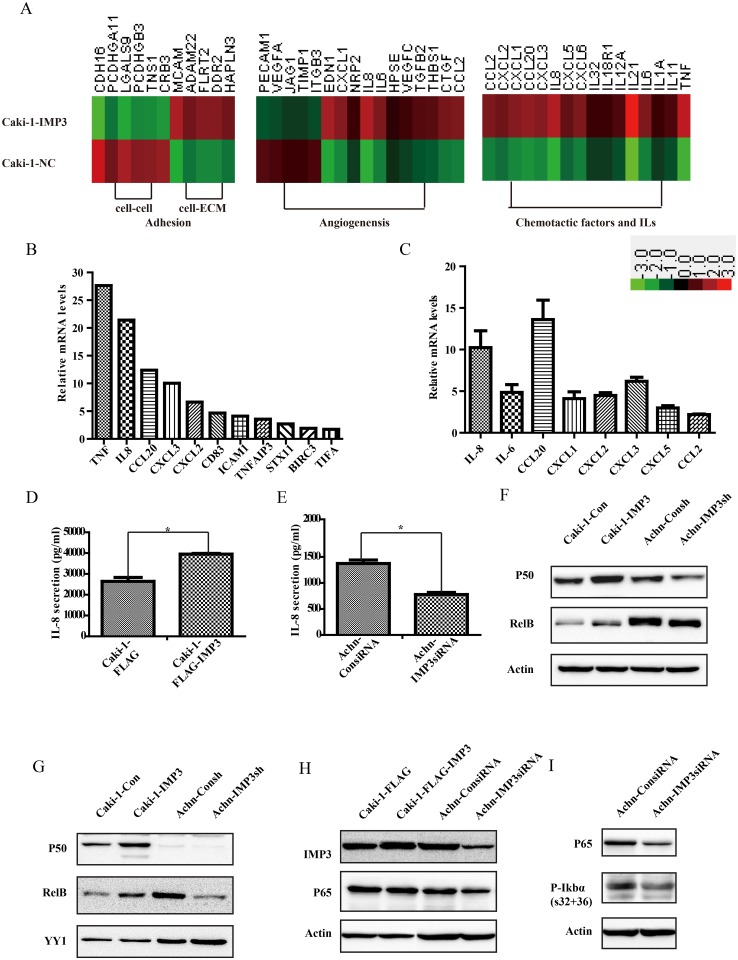
IMP3 overexpression activates NF-κB signaling pathway in CCRCC cells.Genes involved in adhesion, angiogenesis, chemotactic factors and interleukins in IMP3 overexpressed Caki-1 cells were showed in heat maps (A). NF-κB pathway active signature genes were upregulated in IMP3 overexpressed Caki-1 cells by RNA sequencing (B). Relative mRNA expression of cytokines was detected by real-time PCR in IMP3 overexpressed Caki-1 cells (C). The Caki-1 cells were transfected with Flag-IMP3 vector. Forty eight hoursh after transfection, the culture medium was removed and added with serum free medium for 24 h, the medium was harvested. The secretion of IL-8 was detected by ELISA. Values are means ± SD of three independent experiments. * p<0.05 vs. empty vector (D). The Achn cells were transfected with IMP3 siRNA or control siRNA. The identical management was given to cells as shown in D. * p<0.05 vs. control (E). Western blot analyses of P50 and RelB expression in total protein (F) and nuclear extracts (G) in IMP3 overexpressed Caki-1 cells and Achn knockdown cells. Actin and YY1 were used to control the loading. The Caki-1 cells were transfected with Flag-IMP3 vector. The Achn cells were transfected with IMP3 siRNA or control siRNA. Forty eight hours after transfection cells were harvested, the expression of P65 (H) and p-IκBα (I) was detected by Western blot.